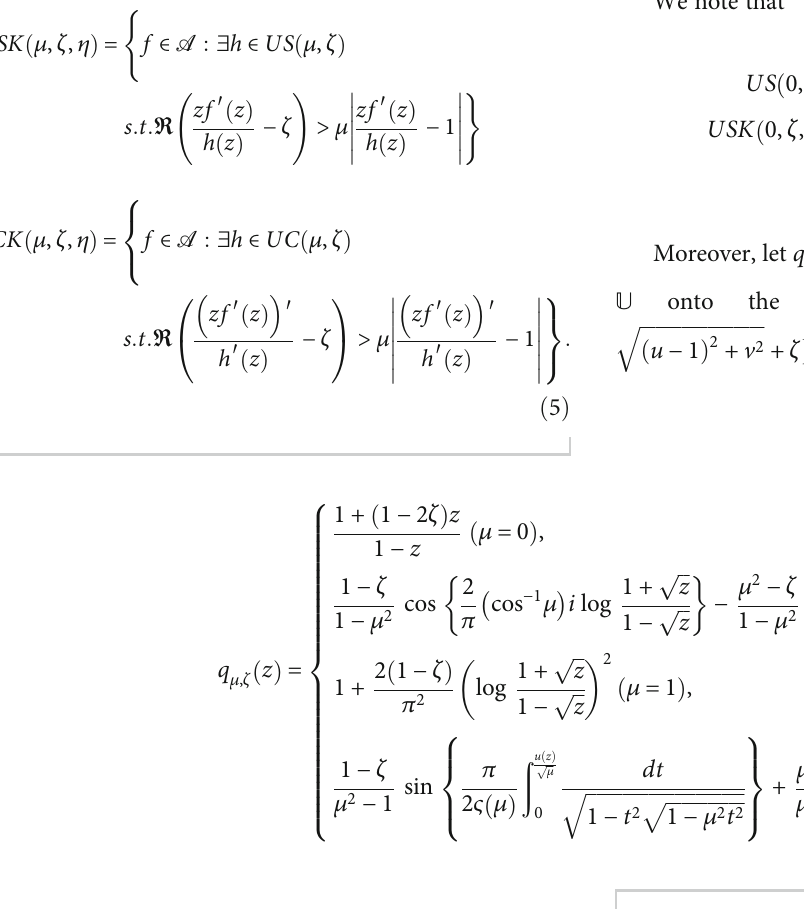
dt ffiffiffiffiffiffiffiffiffiffiffiffiffiffiffiffiffiffiffiffiffiffiffiffiffiffiffiffiffiffiffi